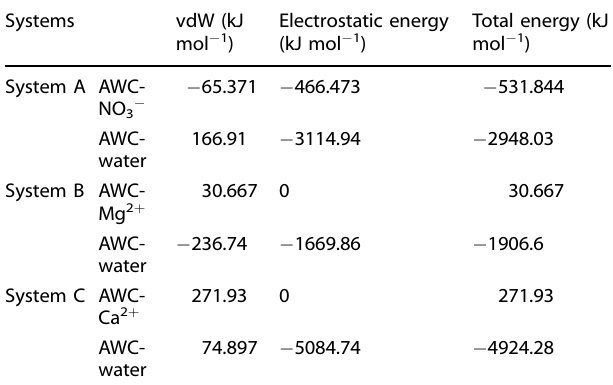
Table 1. The L-j, electrostatic and total energies (all in (kJ mol − 1 )) of the three studied